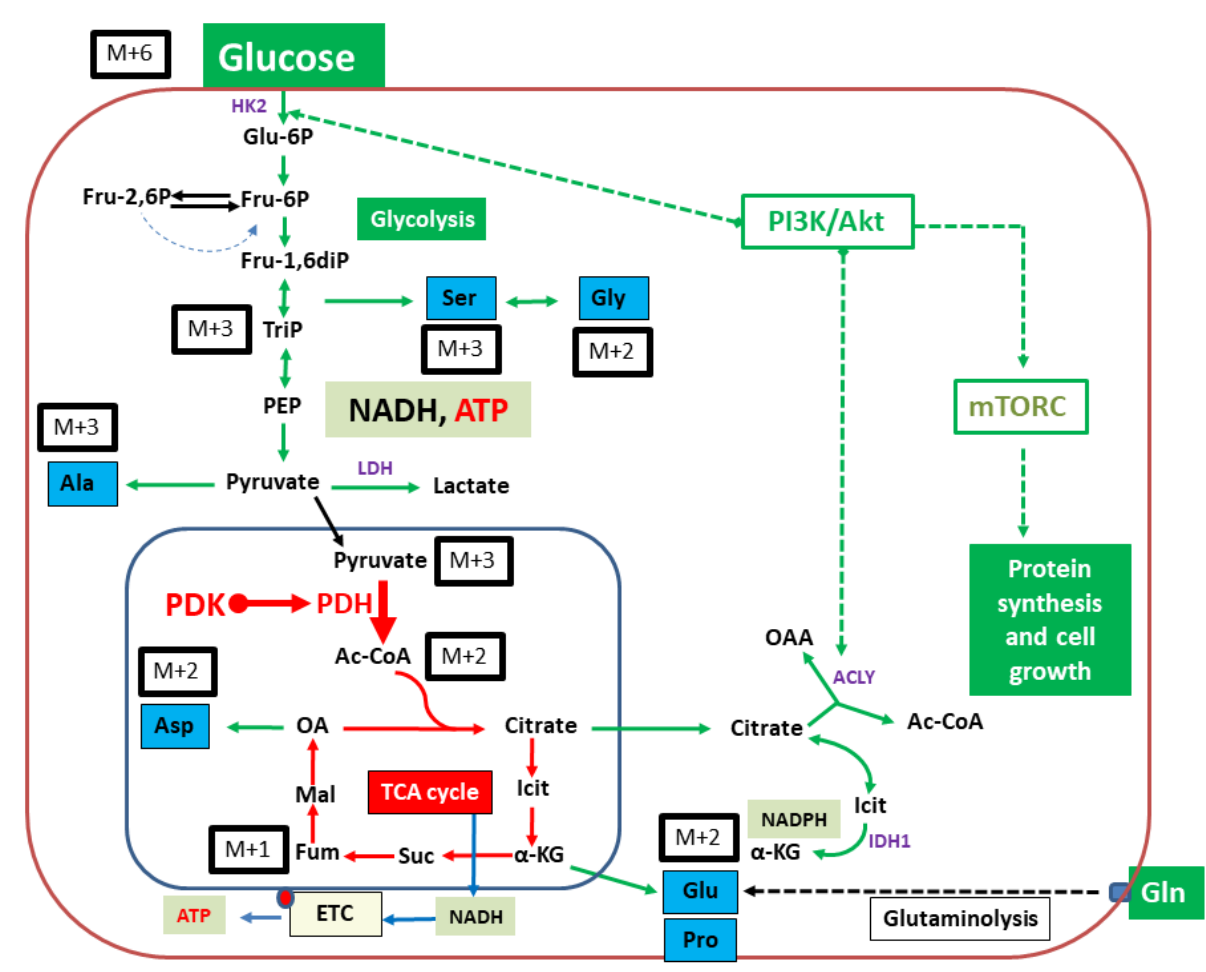
Figure 2. Typical core metabolism in cancer cells controlled by upregulated PI3K/Akt/mTORC. Green arrows indicate metabolic flux at high efficiencies. Notably, glucose uptake and utilization via glycolysis are upregulated. Flux via the TCA cycle and oxidative phosphorylation is downregulated by PDH inactivation due to phosphorylation catalyzed by PDK. When starting from [U- 13 C 6 ]glucose (M + 6) as a carbon substrate, the resulting 13 C-isotopologues in key metabolites and amino acids (in blue boxes) are indicated. M + 3 and M + 2 indicate molecules carrying three or two 13 C-atoms, respectively. PDH, pyruvate dehydrogenase; PDK, pyruvate dehydrogenase kinase, ETC, electron transfer chain; HK2, hexokinase 2; ACLY, ATP-citrate lyase; IDH1, isocitrate dehydrogenase